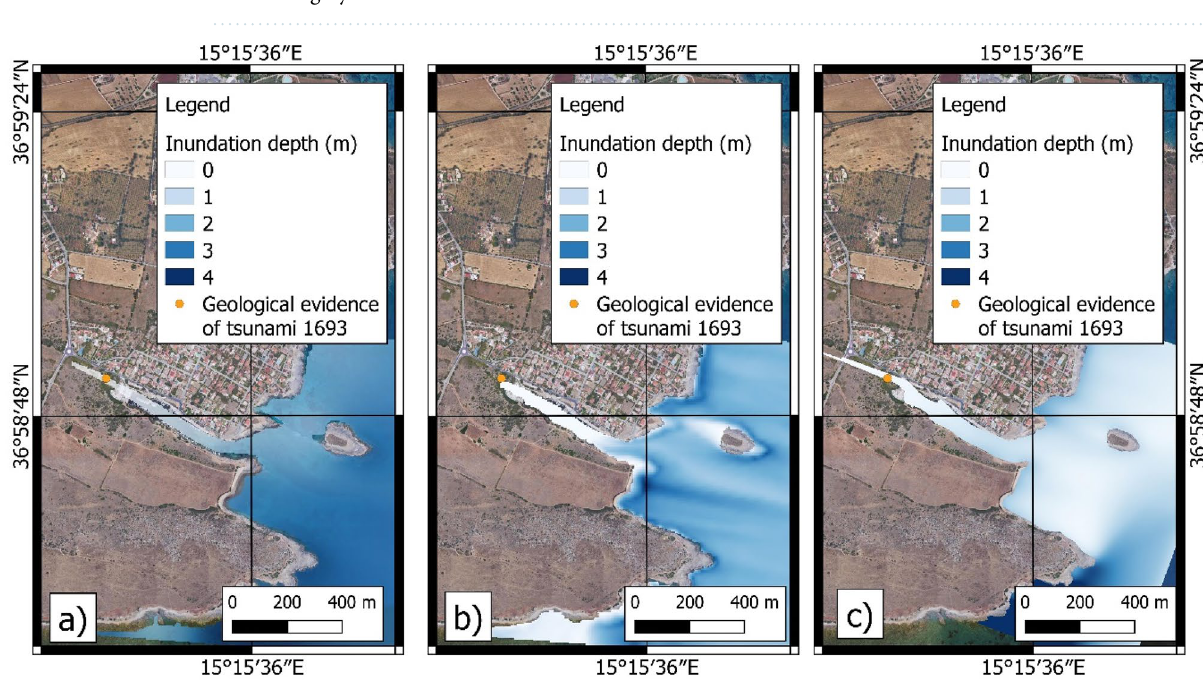
Figure 15. Modelling of tsunami inundation in the Ognina area; ( a ) SFS scenario; ( b ) SLS scenario; ( c ) DTS scenario. The maps were obtained by co-authors through QGIS—software (version 3.14.16); https:// www.